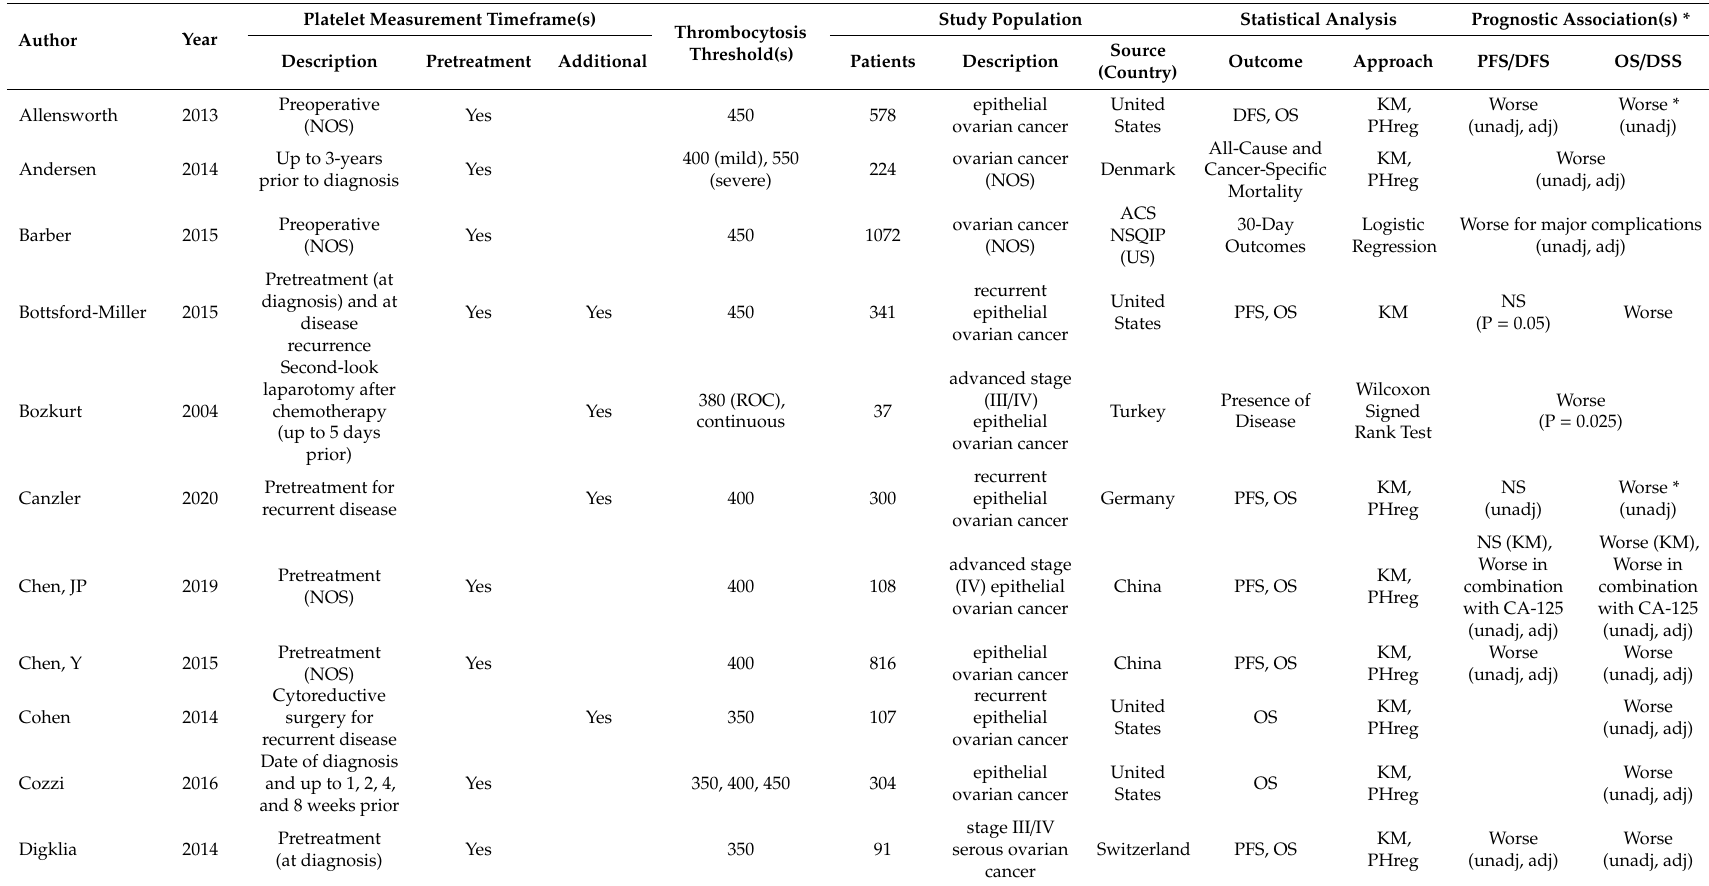
Table 1. Characteristics of Studies on Thrombocytosis and Ovarian Cancer